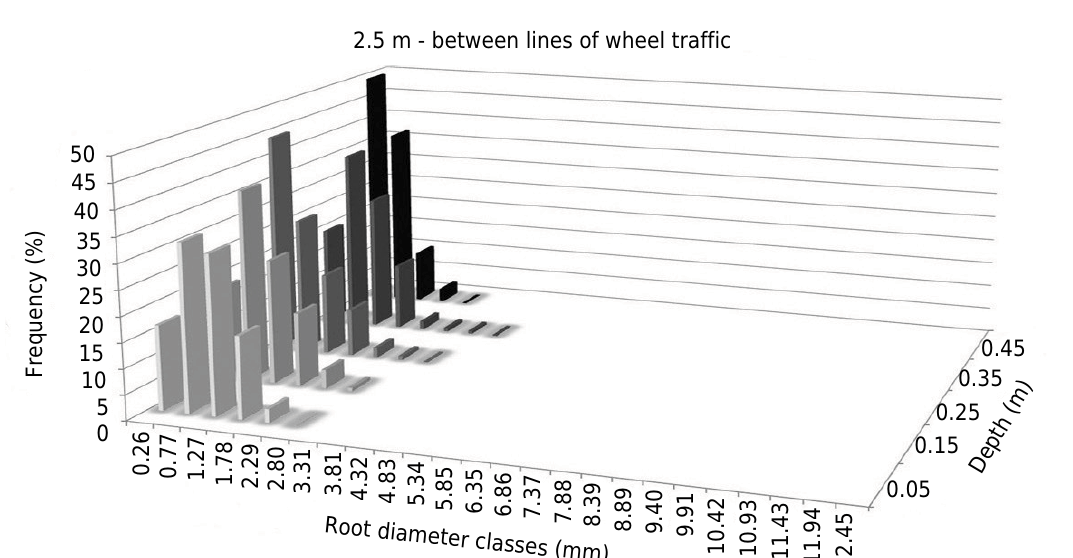
Figure 3. Frequency of root volumes for diameter classes and collection depths under the canopy, in the traffic line of the wheel sets, and in the portion between wheel sets of an orchard of ‘Maciel’ peach grafted onto